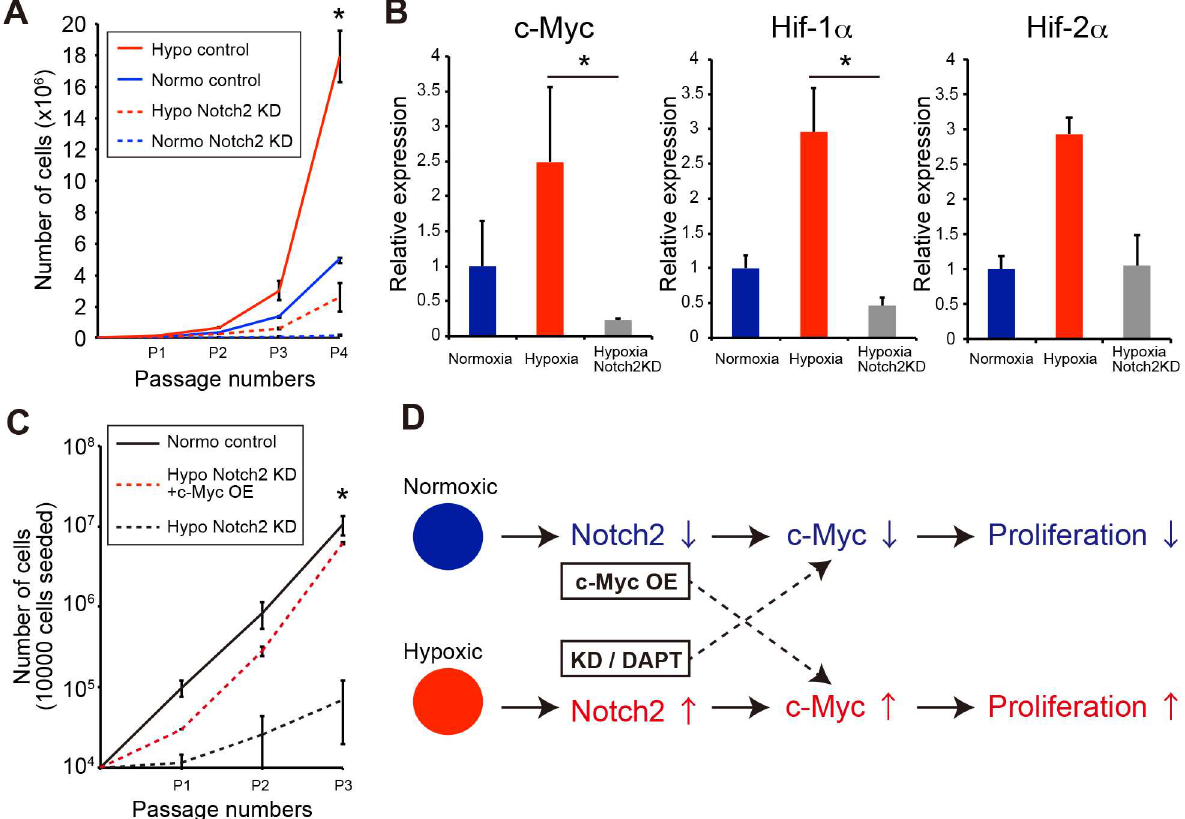
Fig 4. Hypoxia induces c-Myc expression via Notch2 signaling. (A) Proliferation assay of Notch2-KD MSCs. MSCs were cultured under low- or high-oxygen conditions. Notch2 KD was performed using shRNA methods. ControlshRNA = scrambledshRNA. (B) Quantitative real-time PCR assay of c-Myc, HIF-1, and HIF-2 gene expressionunder hypoxic conditions. Normoxiaserved as a control. (C) Overexpression of c-Myc in Notch2-KD MSCs. Notch2-KD P α S-MSCs with or without c-Myc overexpression was culturedfor three passages.(D) Schema of MSC proliferationunder low- or high-oxygenconditions. Notch2 expression, together with the downstream expressionof c-Myc, is higherunder hypoxic conditionsthan under normoxic conditions. However, c-Myc expressionis decreased by a Notch signalinginhibitor (DAPT), leadingto the progression of senescence. Overexpression of c-Myc promotes cell proliferationand delays cell